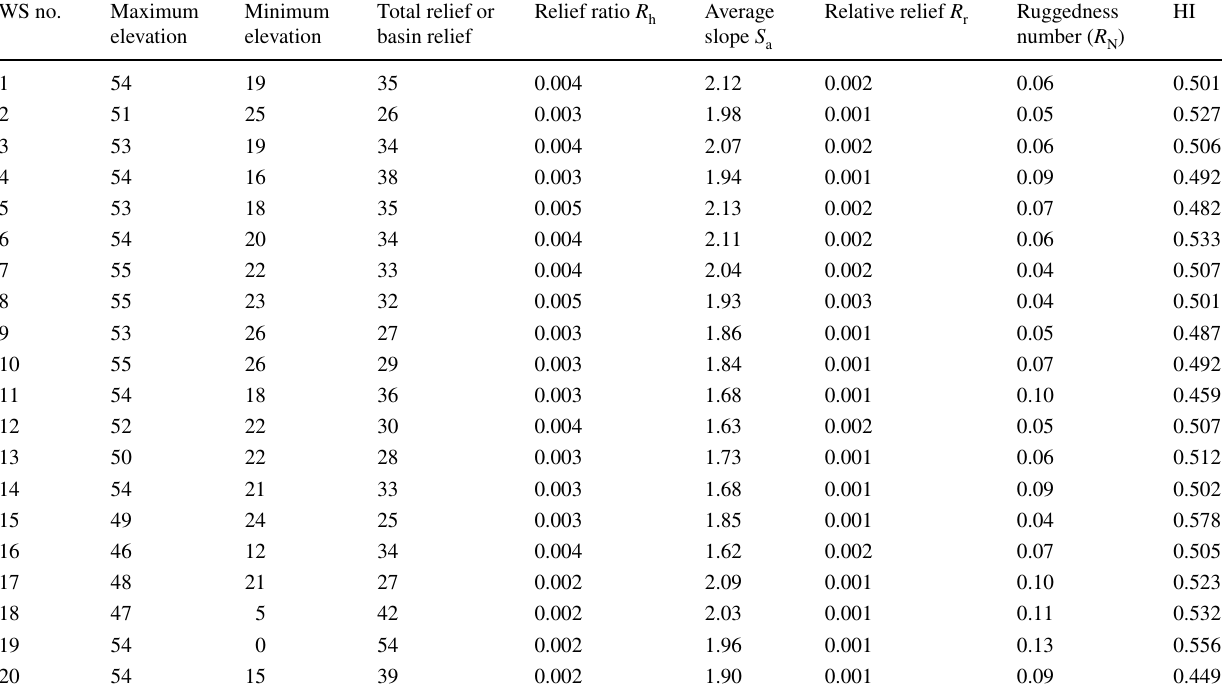
Table 6 Relief aspect of watersheds WS